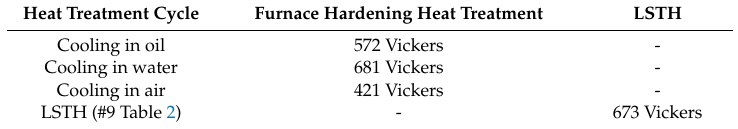
Figure 13. Mixture of ferrite and martensite phase and the percentage profile in maximum surface hardness. ( a ) Percentage profile in maximum surface hardness; ( b ) 200X of sample #9; ( c ) 500X of sample #9.